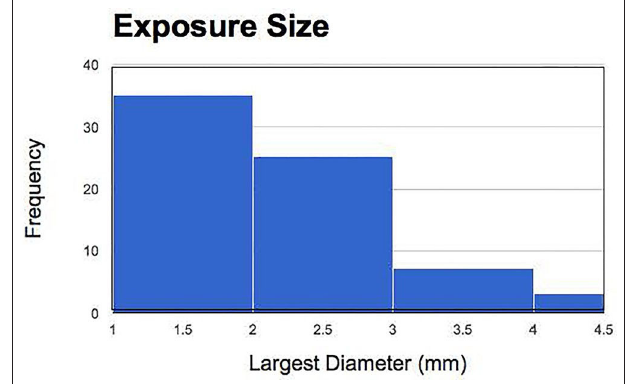
FIGURE 1 | Distribution of pulpal exposure